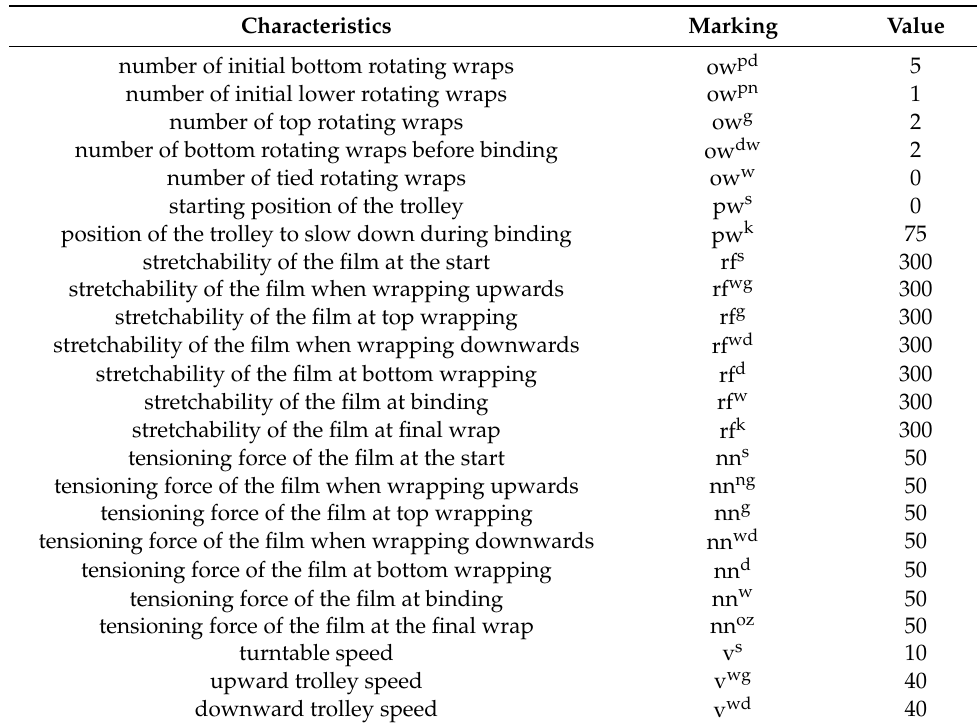
Table 7. Characteristics of cargo application with non-standard film. Characteristics Marking